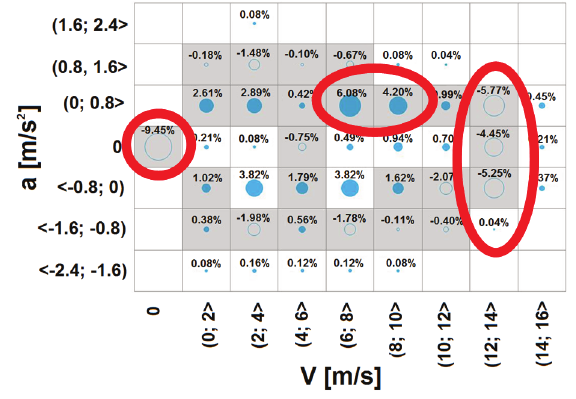
Fig. 25. Difference in the operating time density of test vehicles between measurements on the test route and in the SORT 2 test, shown in the